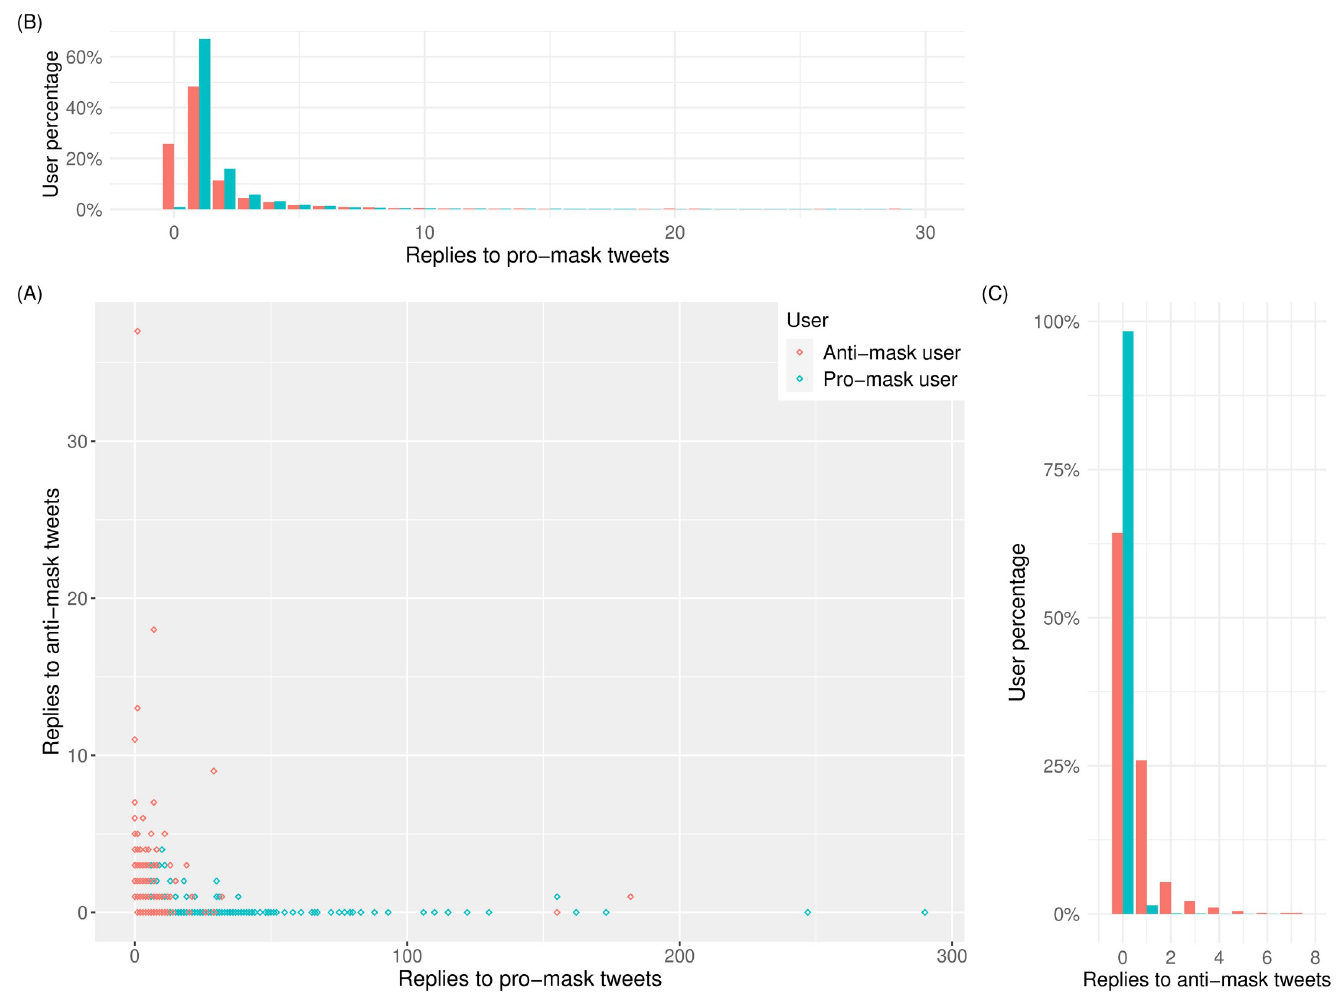
Fig 5. (A) Scatter plot of each user’s replies to anti- and pro-mask tweets, with each red circle representing an anti-mask user and each teal circle representing a pro- mask user. The horizontal and vertical axes indicate the number of a user’s replies to pro-mask tweets and to anti-mask tweets, respectively. (B) Distributions of replies to pro-mask tweets where the 0-reply teal bar is minimal in contrast to the 0-reply red bar representing over 20% of anti-mask users. (C) Distributions of replies to anti-mask tweets where the 0-reply teal bar representing 99% of pro-mask users sticks out on the horizontal axis, towering over the 0-reply red